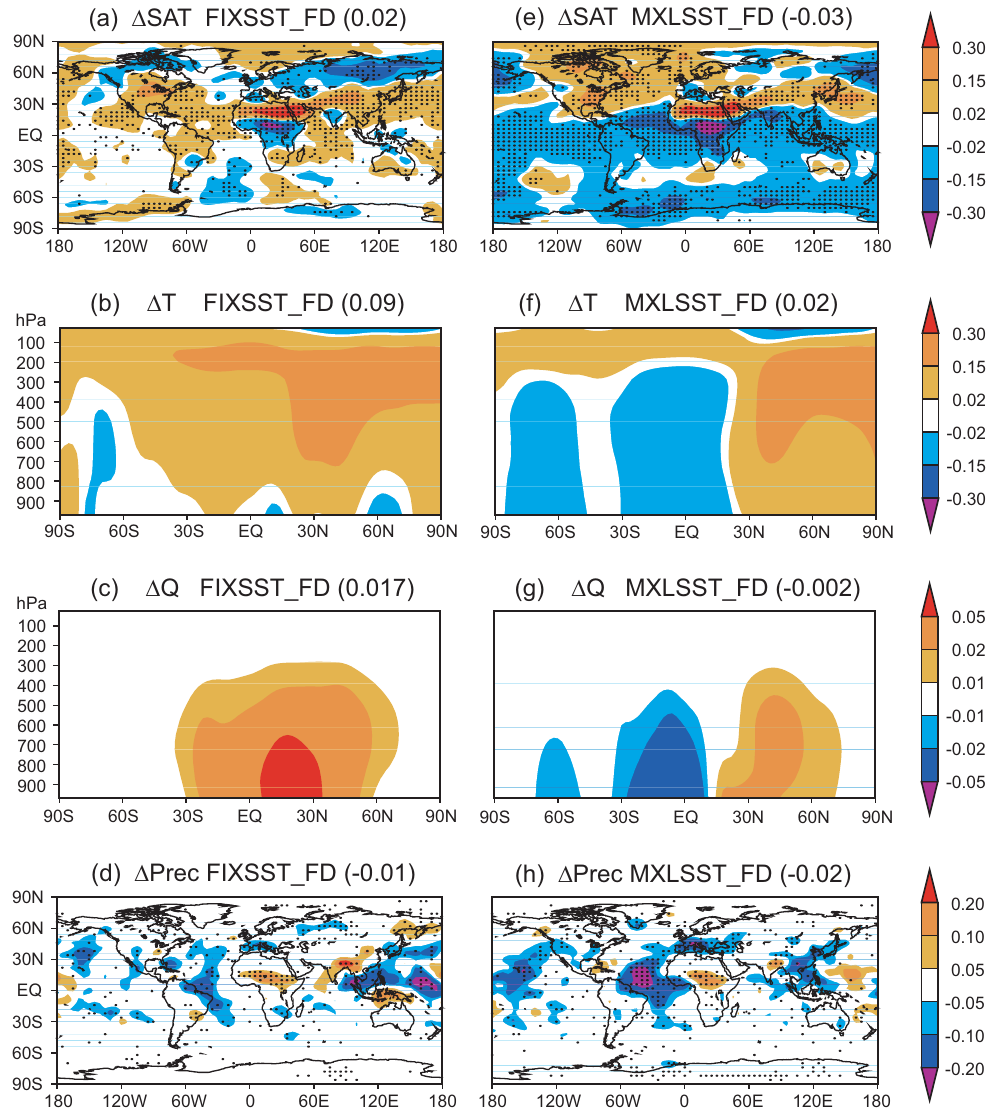
Fig. 4. Simulated dust-induced changes in annual mean surface air temperature (K, top row), annual and zonal mean air temperature (K, second row), annual and zonal mean specific humidity (gkg − 1 , third row), annual mean precipitation (mmday − 1 , bottom row). Left panels: Dust-induced changes in meteorological fields with fixed dust density and fixed SST (FIXSST FD – FIXSST CTRL). Right panels: dust- induced changes with the mixed-layer ocean and fixed dust density (MXLSST FD – MXLSST CTRL). The global mean values are shown in the brackets. Differences that pass the 95% significance level are denoted with dots.